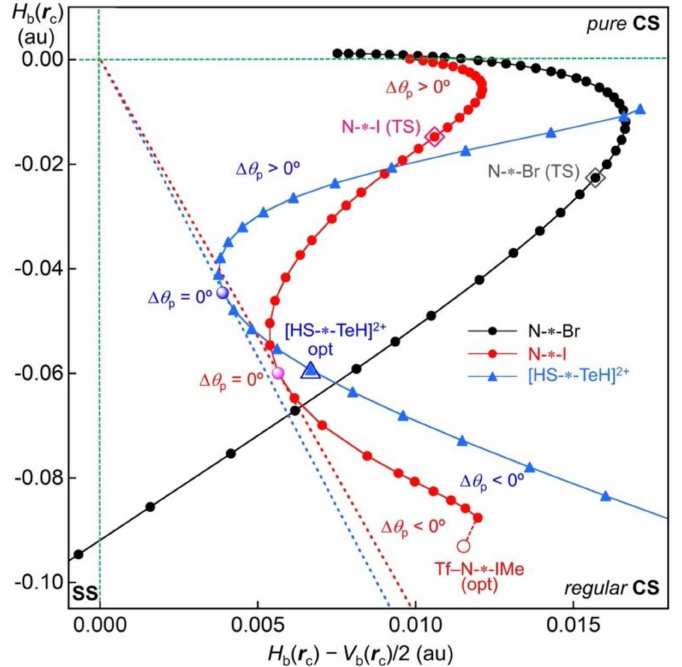
Figure 11. Illustrations for the cases of ∆ θ p = 0, >0 and/or <0, using the plot of H b ( r c ) versus H b ( r c ) − V b ( r c )/2 for a wide range of interaction distances for [HS- ∗ -TeH] 2+ (partial figure) and TS [MeI- ∗ -N(Tf)- ∗ -BrMe]. The perturbed structures are generated with POM for [HS- ∗ -TeH] 2+ and with IRC for the TS. The same scale is not used for the x - and y